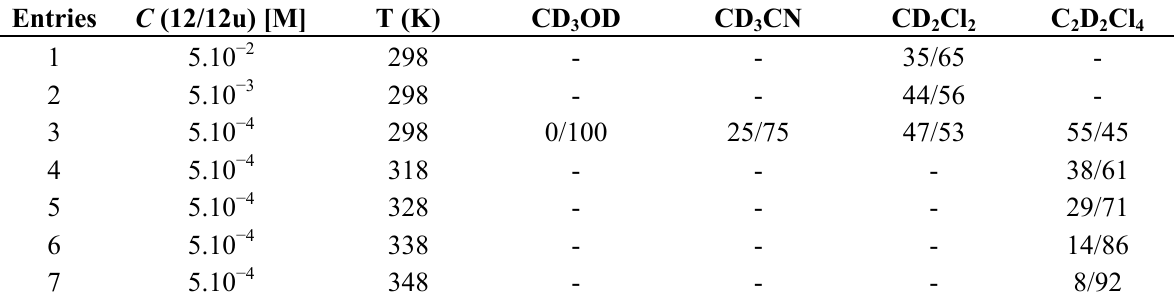
Table 1. Ratio between lasso compound 12 and unthreaded molecule 12u depending on concentration, solvent and